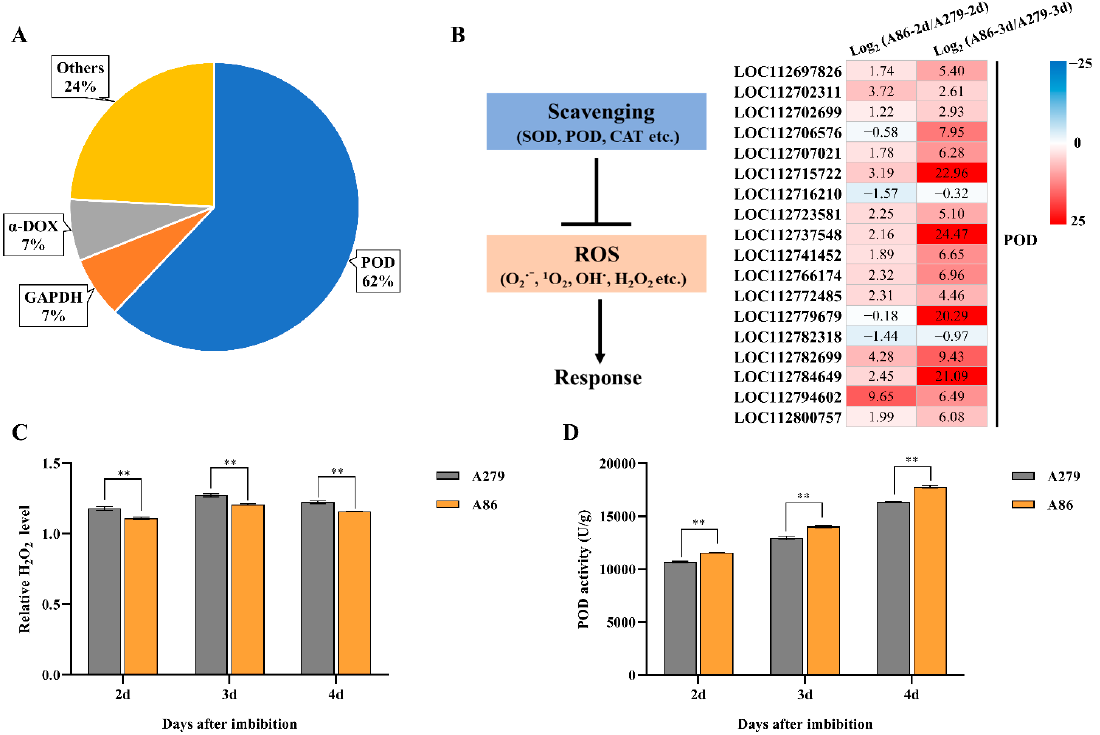
Figure 7. The expression of DEGs involved in oxidative stress. ( A ) Pie chart showing the frequency distribution of DEGs involved in oxidative stress. ( B ) Heat ‐ map showing the differences in the expression of representative genes related to the ROS signaling pathway. ( C , D ) Comparison of the relative H 2 O 2 level and POD activity at different time points (2, 3, and 4 days after imbibition) between A86 and A279. Differences between A86 and A279 at each time point were analyzed by the Student’s t ‐ test. ** indicates significant difference at p < 0.01.